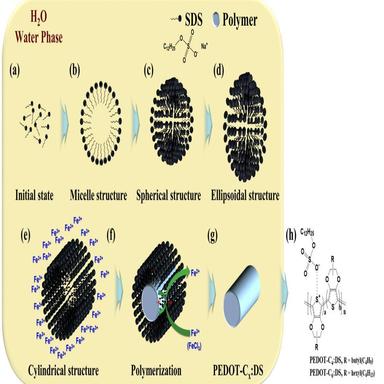
Schematic illustration of the synthetic process in aqueous SDS micelle solution; initial state of SDS (a), the formation of a primary micelle structure of SDS in critical micelle concentration (CMC) (b), gradual changes of SDS from a spherical structure (c) to an ellipsoidal structure (d), the final formation of SDS in a cylindrical structure. After adding FeCl3 oxidant, the cylindrical SDS is surrounded by iron(III) cations to be more cylindrical structure (e), the polymerization of PEDOT-C4 and PEDOT-C6 i